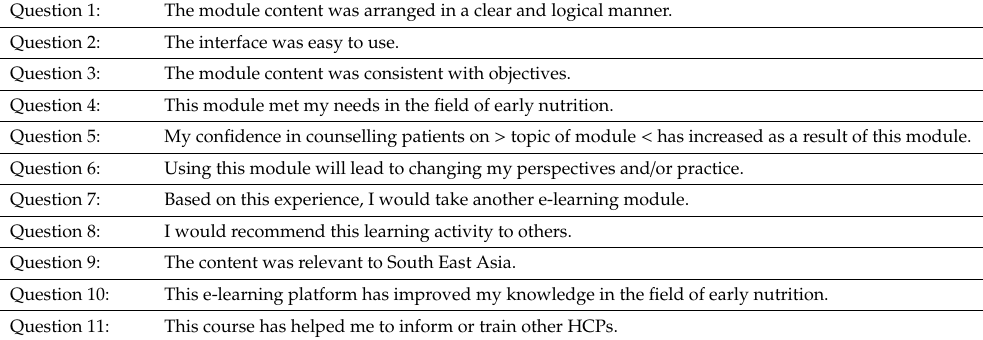
Table A2. Questions included in the evaluation questionnaire of each module. The answer options o ff ered followed a Likert scale with five rating categories (I strongly agree; I agree; I neither agree or disagree; I disagree; I strongly